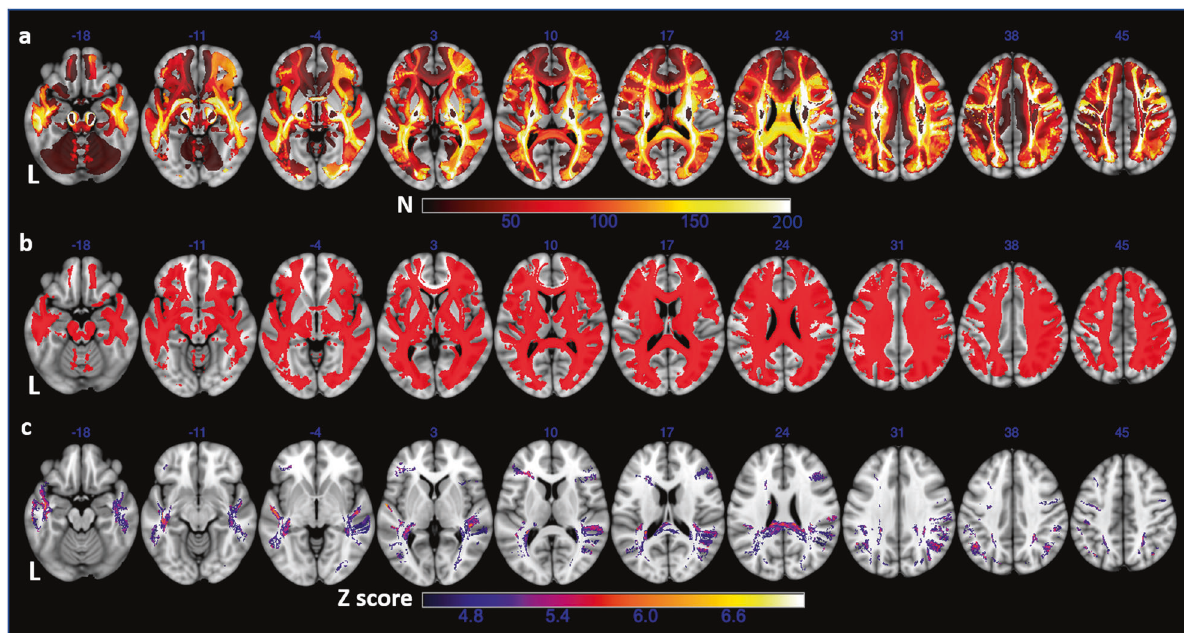
Fig. 2 Results of the primary VDSM analysis in the entire sample. a overlap of 697 binary SDC maps showing SDC frequency across white matter; b only voxels disconnected in at least 5% of patients (i.e. 35 patients) were included in VDSM; c signi fi cant clusters from VDSM that survived FWE-corrected Z threshold of 4.47 and cluster size threshold of 60. Axial coordinates refer to MNI space in mm. L indicates Table 2. Univariable and multivariable logistic regression analyses for the association between SDC score and PSD. Variable